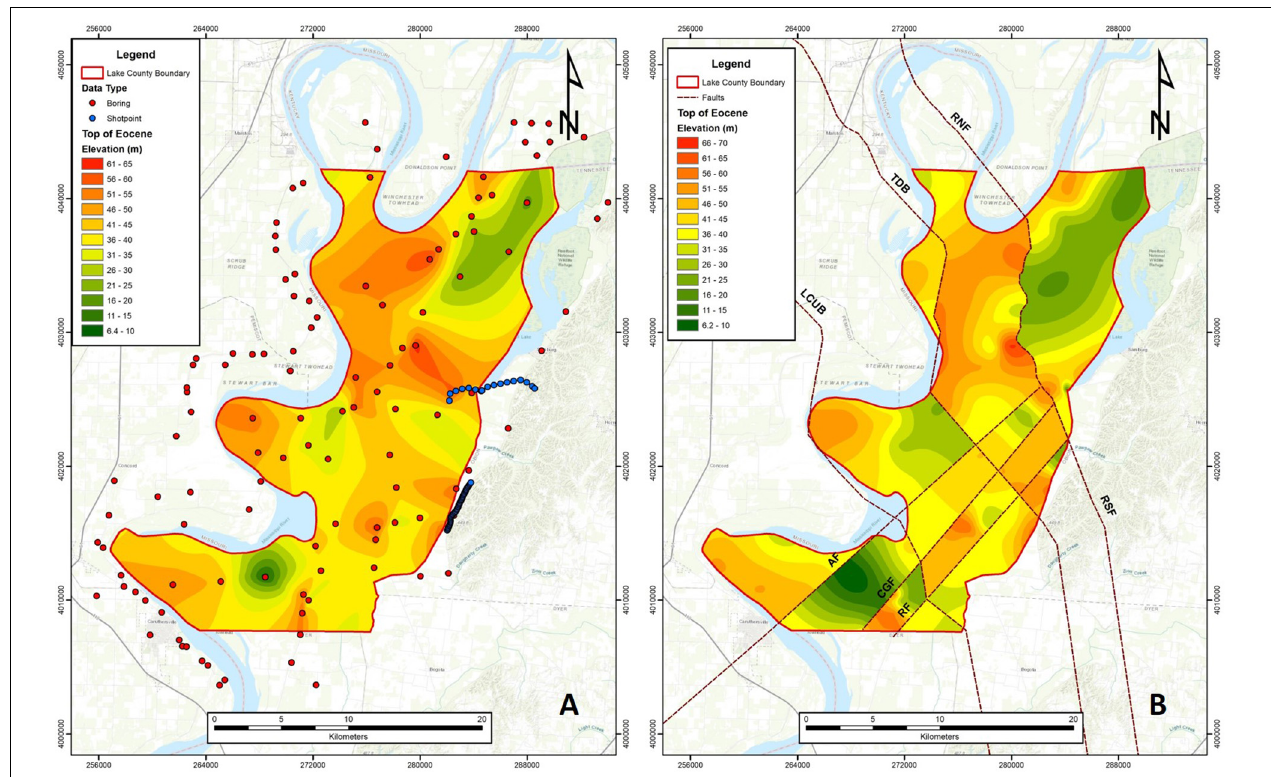
FIGURE 5 | (A) Structure contour map of the top of the Eocene strata. (B) Faulted structure contour map of the top of the Eocene strata. AF, Axial; CGF, Cottonwood Grove; RF, Ridgely; RNF, Reelfoot North; RSF, Reelfoot South; TDB, Tiptonville dome back thrust; LCUB, Lake County uplift back thrust faults. Contour interval is 5